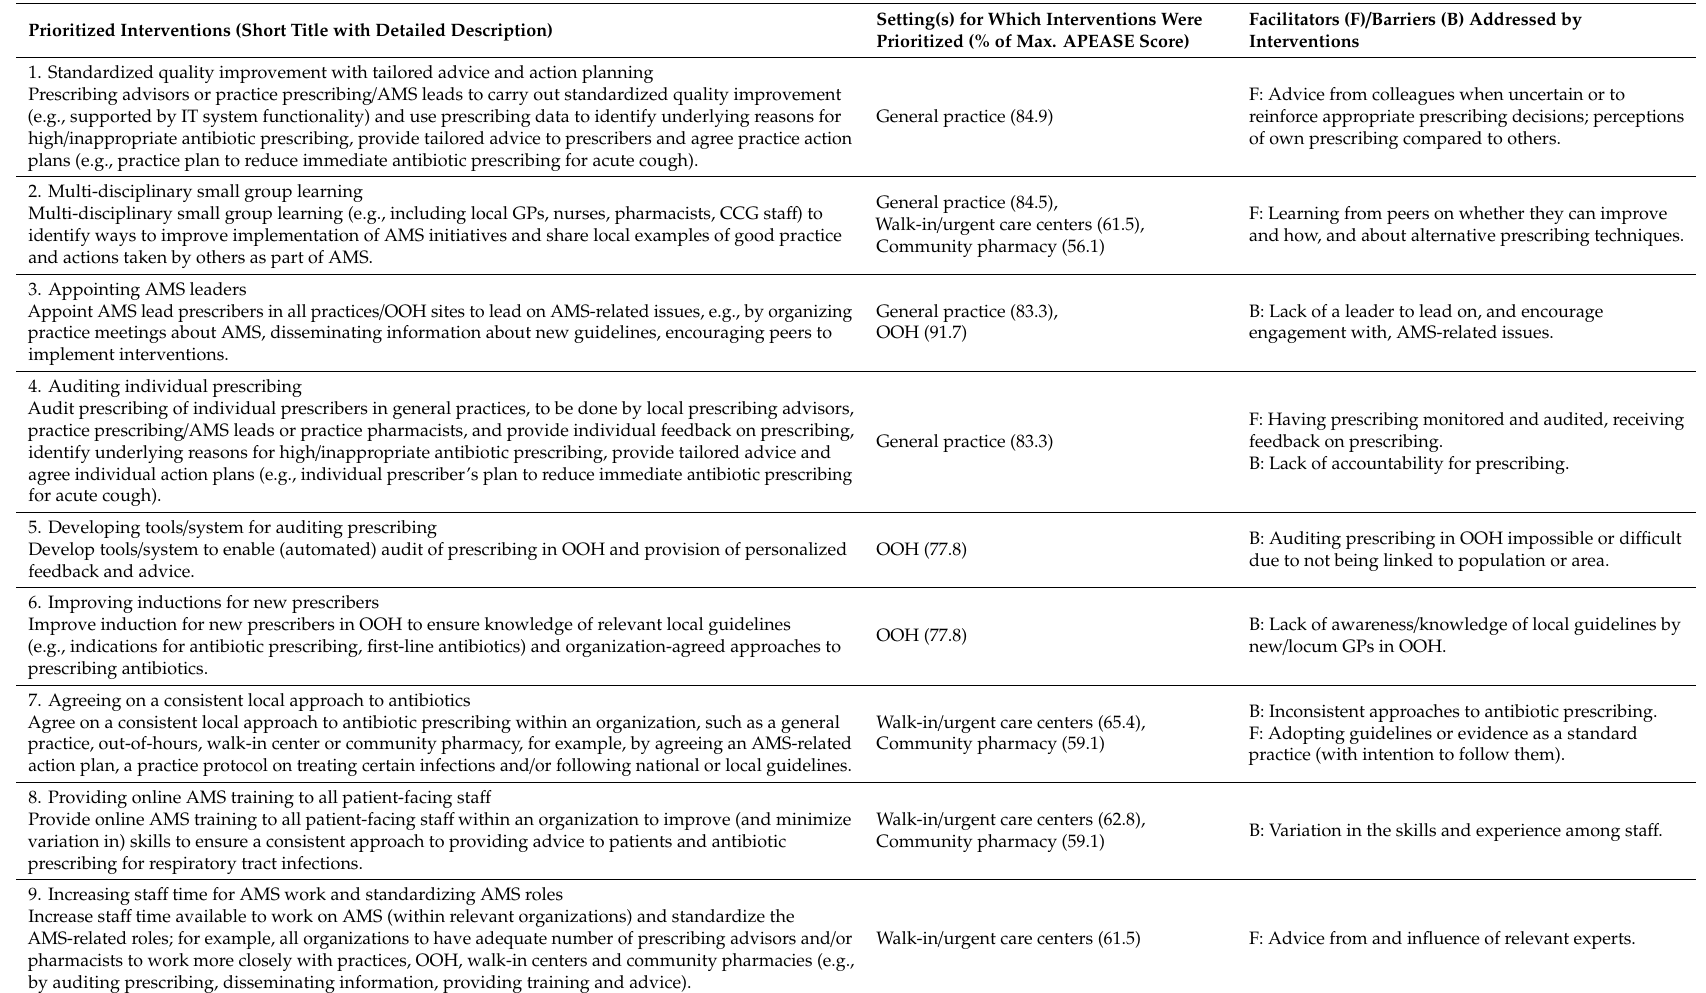
Table 2. Interventions prioritized by